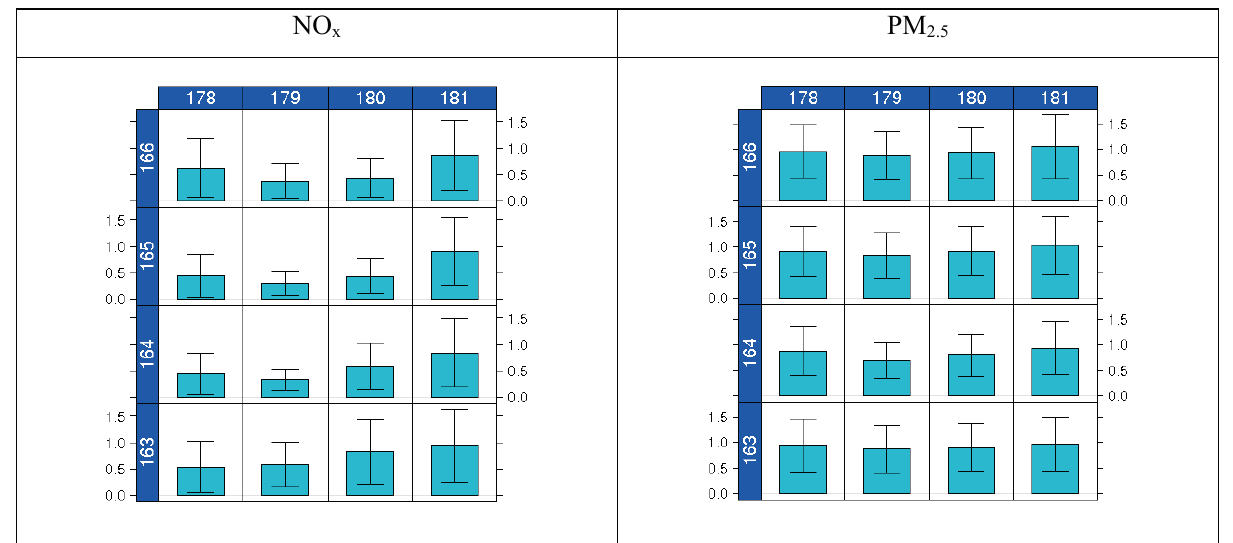
Figure 6. Annual mean and variance of R ZeroOut/Total for NO x and PM 2.5 at the 16 cells where local emissions were removed.